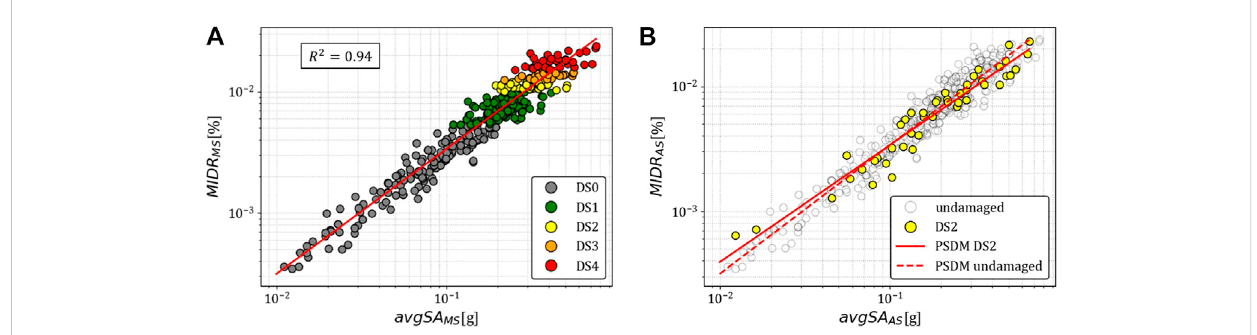
FIGURE 11 Cloud analysis results and PSDM for: (A) undamaged con fi guration and MS only; and (B) initial DS2 con fi guration and AS records.